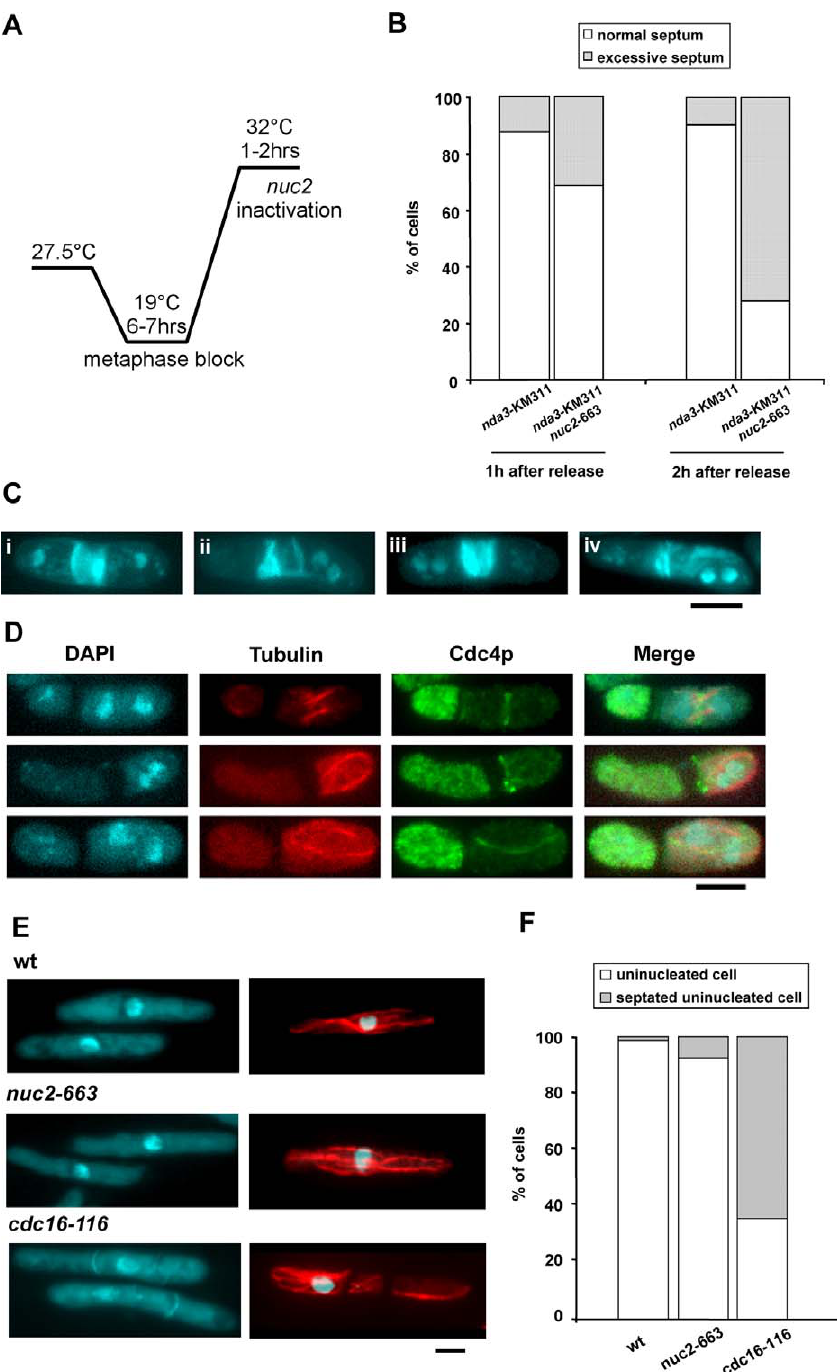
Figure 2. Ectopic Actomyosin Ring and Septum Formation in the nuc2- 663 Mutant After Septation (A) The diagram schematically illustrates the experimental design. (B) Quantification of cells with normal or excessive septa after 1–2 h release from metaphase block. At least 200 cells were counted in each category. (C) Examples of septum patterns in nuc2- 663 nda3- KM311 cells. Four examples of cells with excessive septum material are shown. i and ii, multiseptated cells; iii, excessive deposition of septum material at division site; iv, cell with ectopic misoriented septum. (D) Visualization of actomyosin rings in nuc2 -663 nda3 -KM311 cells by immunofluorescence microscopy. Top, middle, and bottom panels show cells with actomyosin rings that were formed straight, close to, or misoriented with respect to the previous division site, respectively. Microtubules were stained with TAT-1 antibody, and the actomyosin ring was stained with anti-Cdc4p antibody. (E) Septum assembly in S-phase–arrested cells. Wild-type, nuc2- 663, and cdc16- 116 cells arrested in S phase by hydroxyurea treatment were either formaldehyde fixed for DAPI and aniline blue staining or methanol fixed for immunostaining with TAT-1. (F) Quantification of septated cells versus non-septated cells upon hydroxyurea treatment. At least 300 cells were counted for each category. Scale bar, 5 l m.